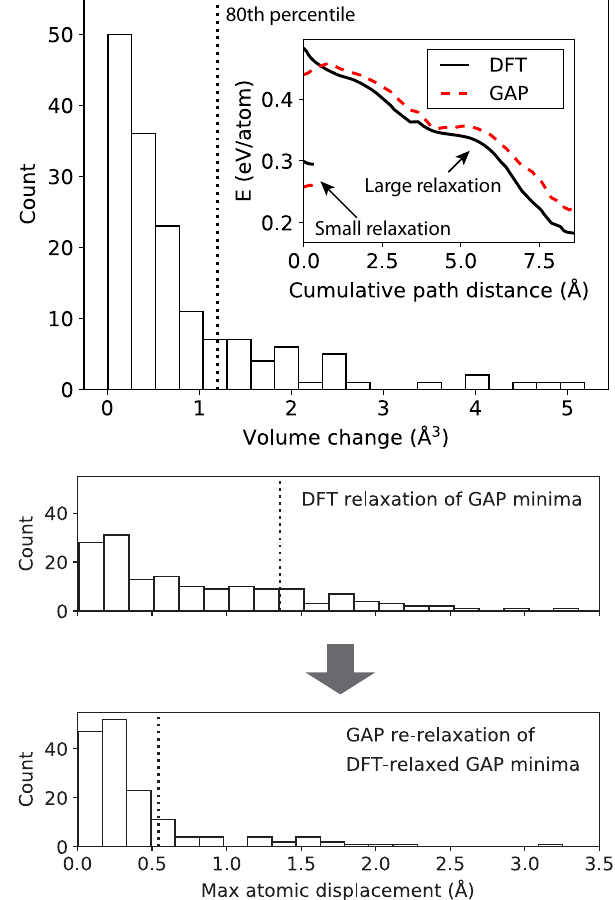
FIG. 18. The top shows the distribution of volume changes for the relaxation of GAP minima using the DFT. The dotted vertical line indicates the 80th percentile. The inset shows the energy per atom for trajectories generated by DFT relaxation starting from the GAP RSS minimum, computed with the DFT (black solid line) and GAP (red dashed line), for one configuration with a small volume change and one with a large volume change. The inset horizontal axis is the cumulative Euclidian distance along the relaxation path. The remaining panels show the distributions of atomic displacements for the DFT relaxation of the GAP minima (center) and the GAP rerelaxation of the DFT-relaxed GAP minima